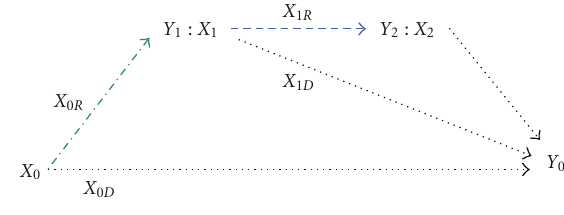
Figure 6: A class of orthogonal relay